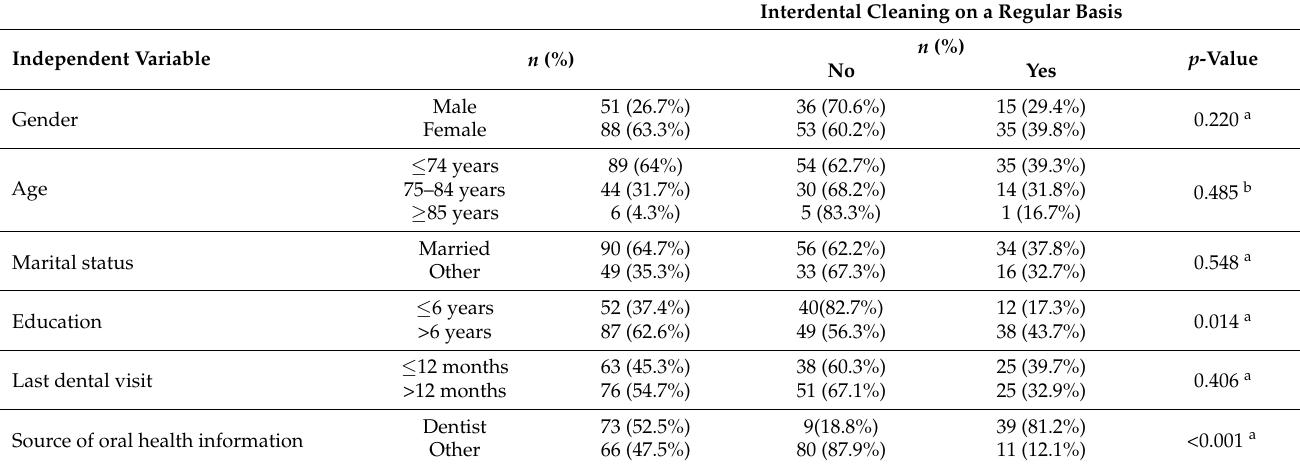
Table 6. The association of sociodemographic characteristics, dental visitation habits and source of daily dental hygiene information with regular interdental cleaning in dentate